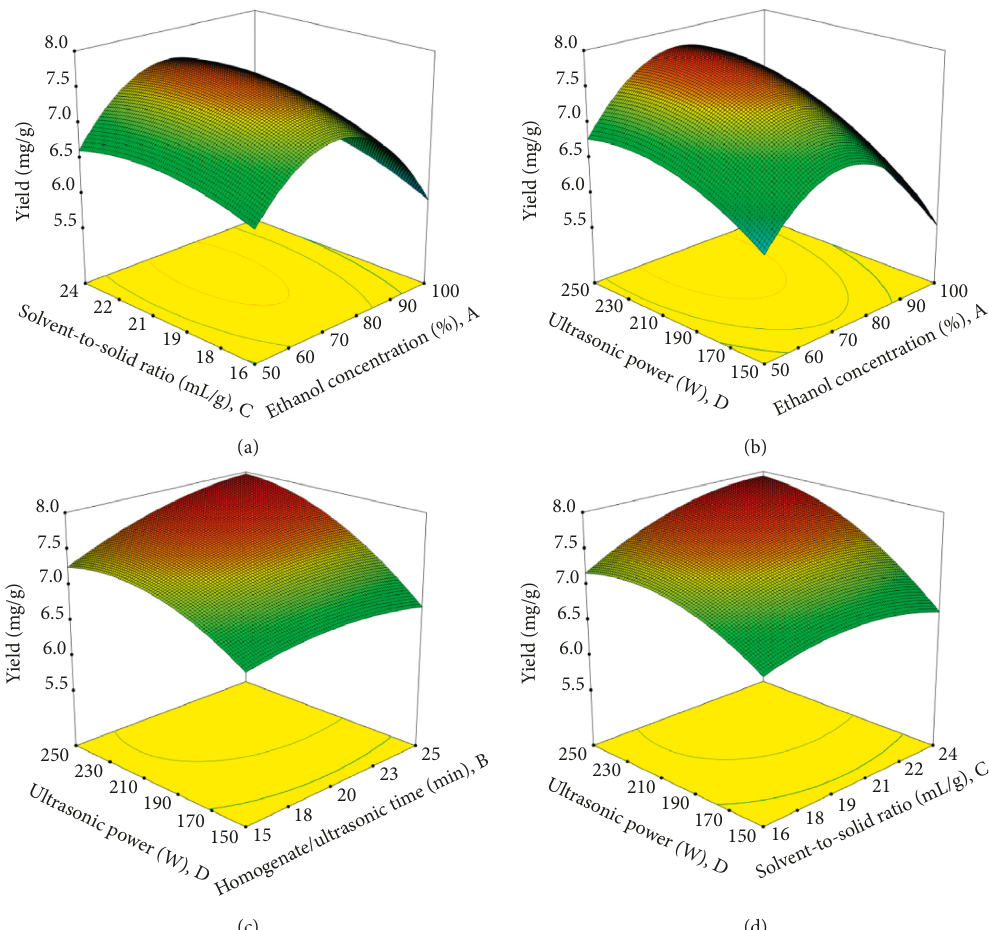
Figure 2: Response surface and contour plots. (a) The reciprocal interaction of ethanol concentration and solvent-to-solid ratio on extraction yield. (b) The reciprocal interaction of ethanol concentration and solvent-to-solid ratio on the extraction yield. (c) The reciprocal interaction of homogenate/ultrasonic time and ultrasonic power on HUCSE process. (d) The interactive effect of solvent-to-solid ratio and ultrasonic power on the extraction